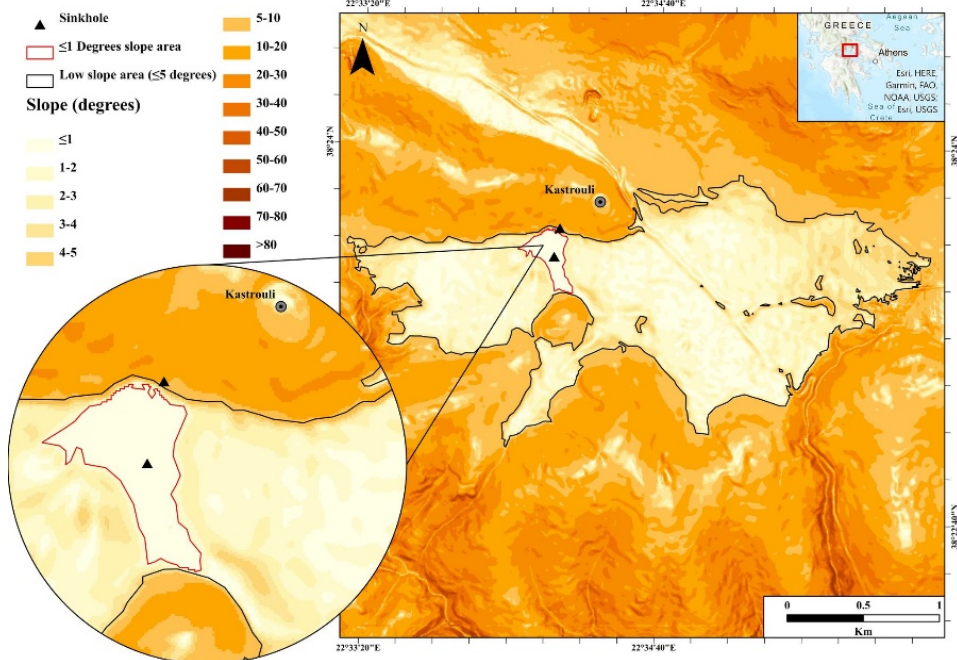
Figure 10. Morphological slopes of Kastrouli area. The black outline identifies the area with inclina- tions fluctuating between 0 and 5 degrees (0 and 8.75%). On the contrary, the red outline indicates an area of 0.06 Km 2 , with inclinations fluctuating between 0 and 1 degrees (0 and 1.75%). Gray tri- angles are the sinkholes.